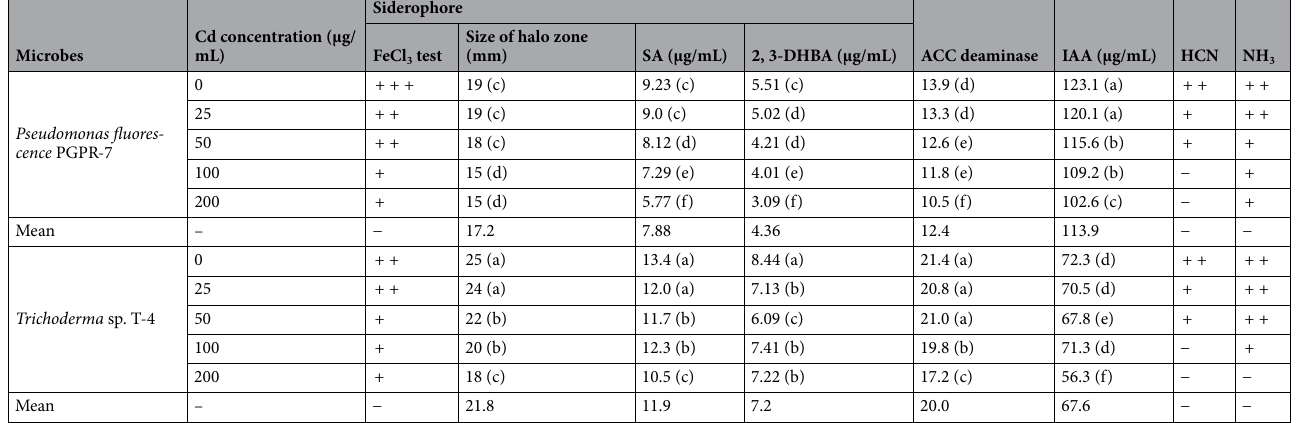
Table 2. Plant growth regulating activities of HMs tolerant microbes under Cd stress. Value indicates the means (mean ± S.D) of three independent replicates. Means followed by similar alphabets are significantly different from each other according to Duncan’s multiple range test (DMRT). Here, Cd = cadmium, µg/ mL = micrograms per milliliters, FeCl 3 = ferric chloride, SA = salicylic acid, DHBA = dihydroxy benzoic acid, ACC = 1-amino cyclopropane decarboxylate, IAA = indole acetic acid, HCN = hydrogen cyanide, NH 3 =